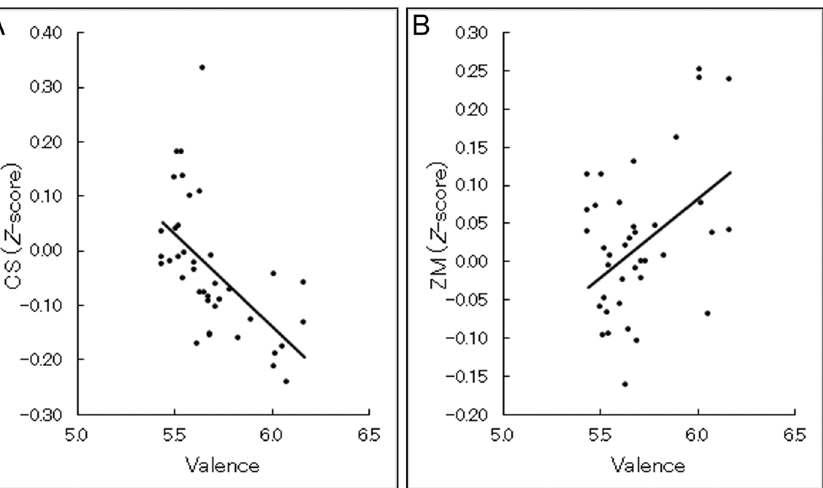
Figure 7. Group-averaged scatterplots and regression lines of relationships between continuous subjective valence ratings and facial electromyography (EMG) signals in Experiment 2. The facial EMG data were recorded from the corrugator supercilii (CS) ( A ) and zygomatic major (ZM) ( B ) muscles using the wearable device. The facial EMG data were standardized within individuals.